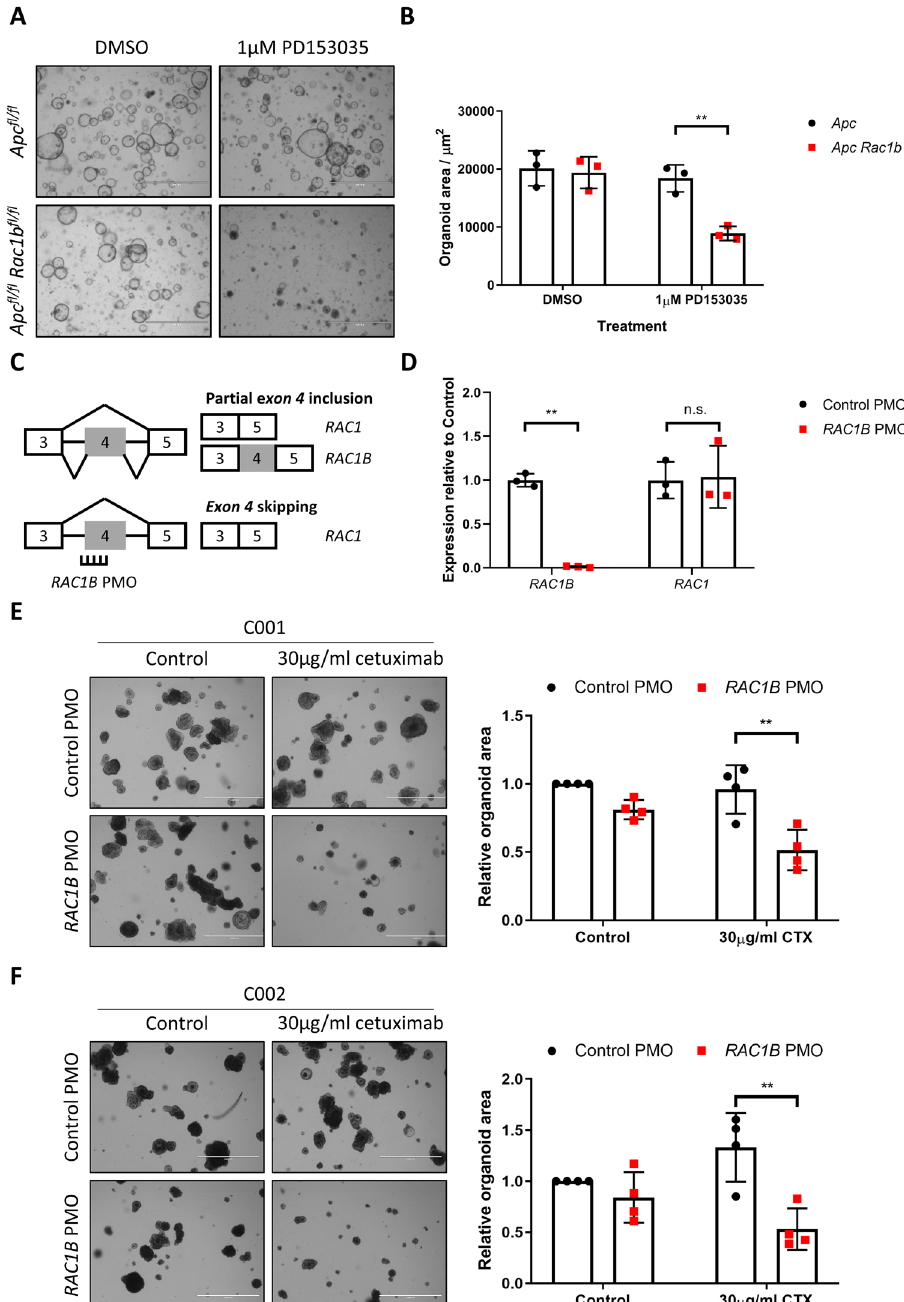
Fig. 7 Depletion of RAC1B in human tumour organoids sensitises to EGFR inhibition. A Representative images of Apc fl / fl and Apc fl / fl Rac1b fl / fl organoids grown with or without the EGFR inhibitor PD153035. Scale bars are 1000 µ m. B Quanti fi cation of organoid size 20 h after addition of PD153035 (data are presented as mean ± SD; ** P = 0.0061; two-way ANOVA with Tukey multiple correction; n = organoids from 3v3 mice). C Schematic outlining design of RAC1B PMO. D qRT-PCR analysis of PDOs treated with control or RAC1B PMO (data are presented as mean ± SD; ** P = 0.0019; two-way ANOVA with Tukey multiple correction; n = 3v3 independent treatment experiments). E Representative images (left panel) and quanti fi cation (right panel) of C001 organoid PDOs treated with control or RAC1B PMO in the presence or absence of cetuximab (left panel) (data are presented as mean ± SD; ** P = 0.0011; two-way ANOVA with Tukey multiple correction; n = 4v4 independent treatment experiments). Scale bars are 1000 µ m. F Representative images (left panel) and quanti fi cation (right panel) of C002 organoid PDOs treated with control or RAC1B PMO in the presence or absence of cetuximab (left panel) (data are presented as mean ± SD; ** P = 0.0019; two-way ANOVA with Tukey multiple correction; n = 4v4 independent treatment experiments). Scale bars are 1000 µ m. Source data are provided as a Source Data fi expression with later tumour stage, presence of metastatic disease BRAF-mutated CMS1 subtype. Apparently contradictory to the and poor prognosis. We also identi fi ed a signi fi cant correlation of survival data, CMS2 subtype CRC is characterised by relatively elevated RAC1B and the WNT high, CMS2 CRC subtype and a good prognosis 1 . We subsequently found that survival of patients negative correlation of RAC1B expression and the MSI high, with CMS2 subtype tumour could be separated based on RAC1B